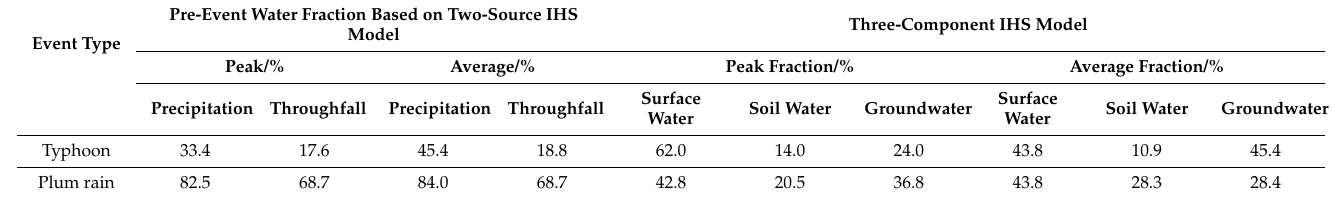
Table 2. Results of isotopic separation model in the Hemuqiao watershed.